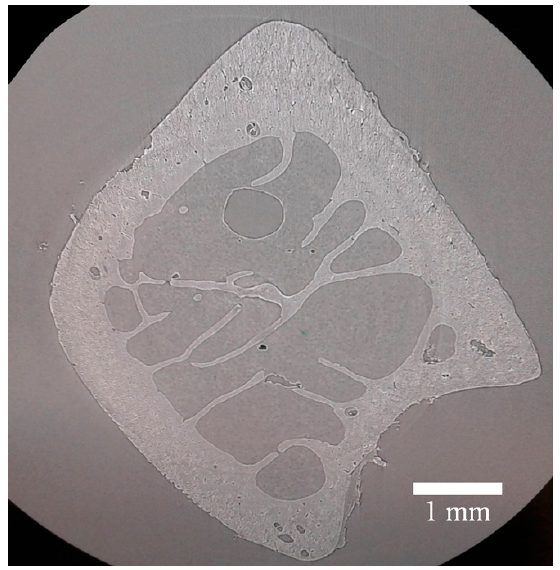
Figure 6. An example of tomographic slice a transverse to the bone extent obtained from the reconstruction of radiographic projections.